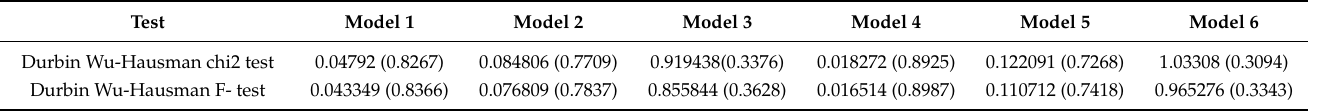
Table 8. Tests for